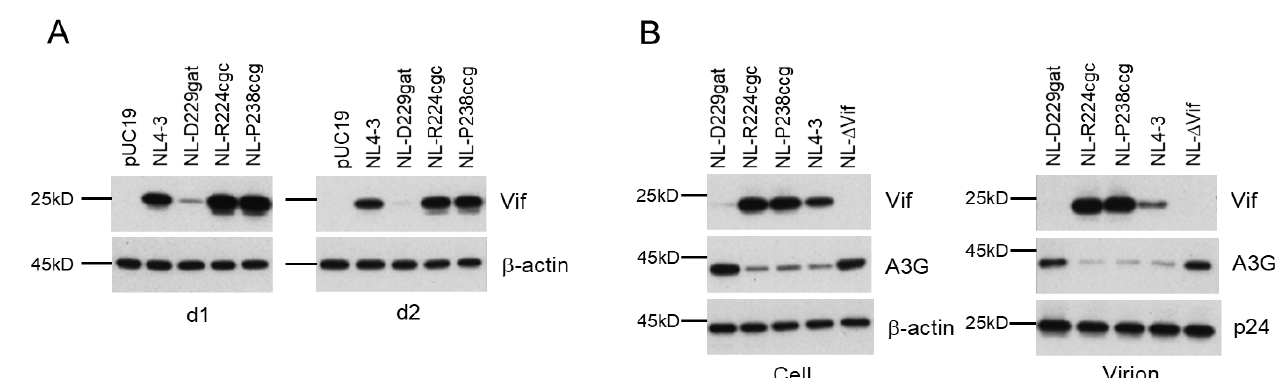
Figure 2. Characteristics of low-Vif type NL-D229gat and excessive-Vif type NL-R224cgc/NL-P238ccg for Vif expression level and A3G degrading activity. ( A ) Vif expression kinetics. HEK 293T cells were transfected with the indicated pro-viral clones. On day 1 and day 2 (d1 and d2, respectively) post-transfection, cell lysates were prepared and subjected to Western blotting analysis using anti-Vif and anti- β -actin antibodies. Representative data from two independent experiments are shown. ( B ) A3G antagonizing activity. The indicated pro-viral clones along with a FLAG-tagged A3G expression vector were co-transfected into HEK 293T cells. On day 1 post-transfection, virions and cells were collected and lysed for Western blotting analysis using anti-Vif, anti-Gag-p24, anti-FLAG, and anti- β -actin antibodies. Representative data from two independent experiments are shown.